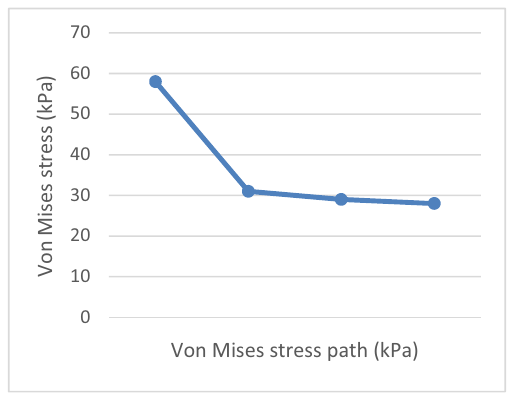
Figure 25: Von Mises stresses